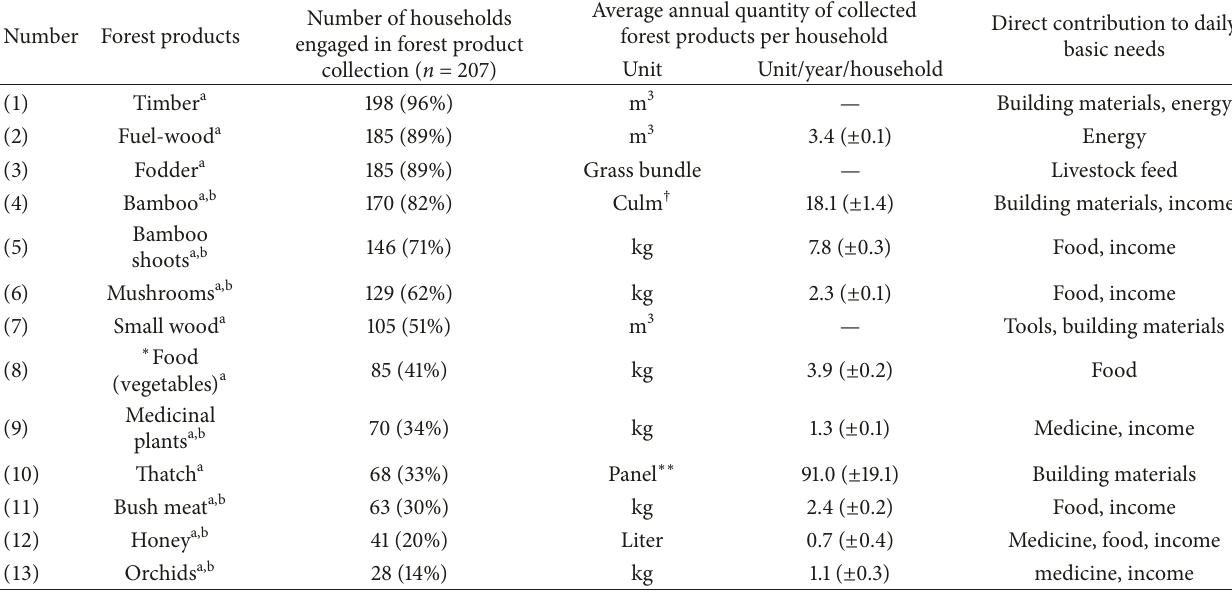
Table 1: Diversity in the collected forest products and their contribution to household’s daily basic needs. Number Forest